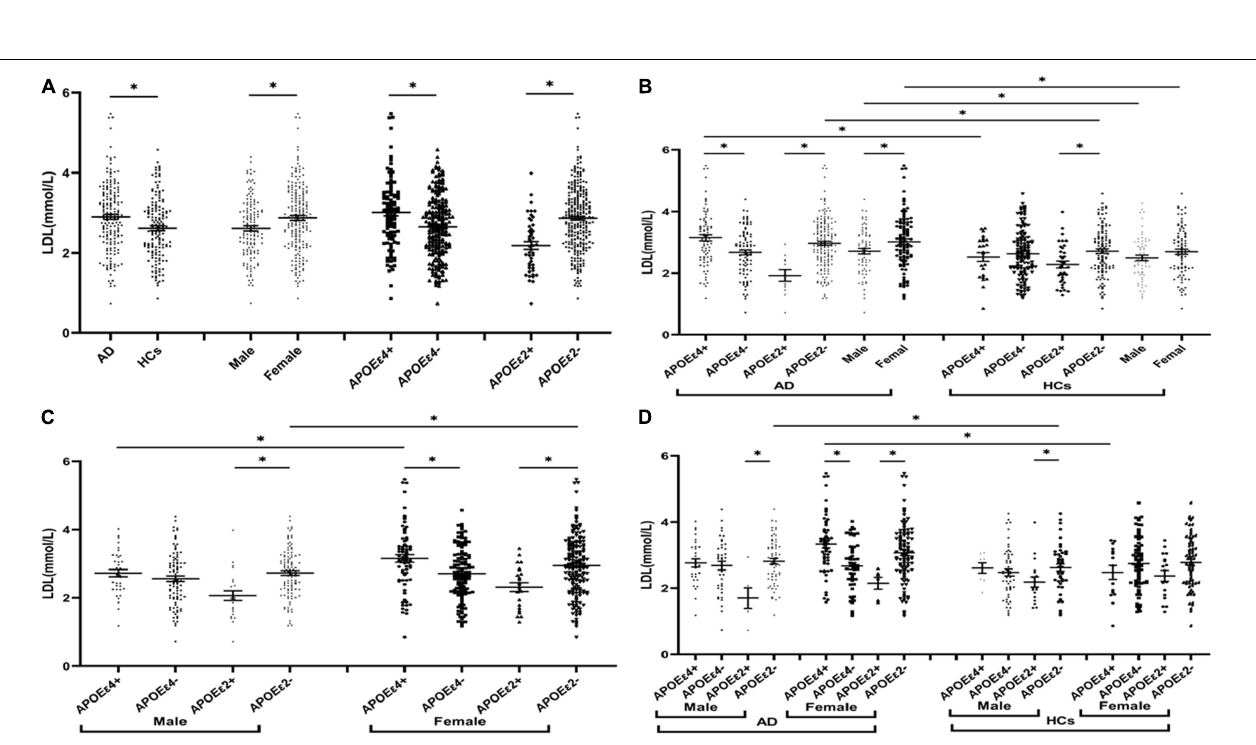
FIGURE 4 | The levels of HDL in different populations. ∗ P < 0.05; Values are expressed as mean (standard error). AD, Alzheimer’s disease; HCs, healthy controls; APOE ε 4 +, APOE ε 4 carriers; APOE ε 2 +, APOE ε 2 carriers.